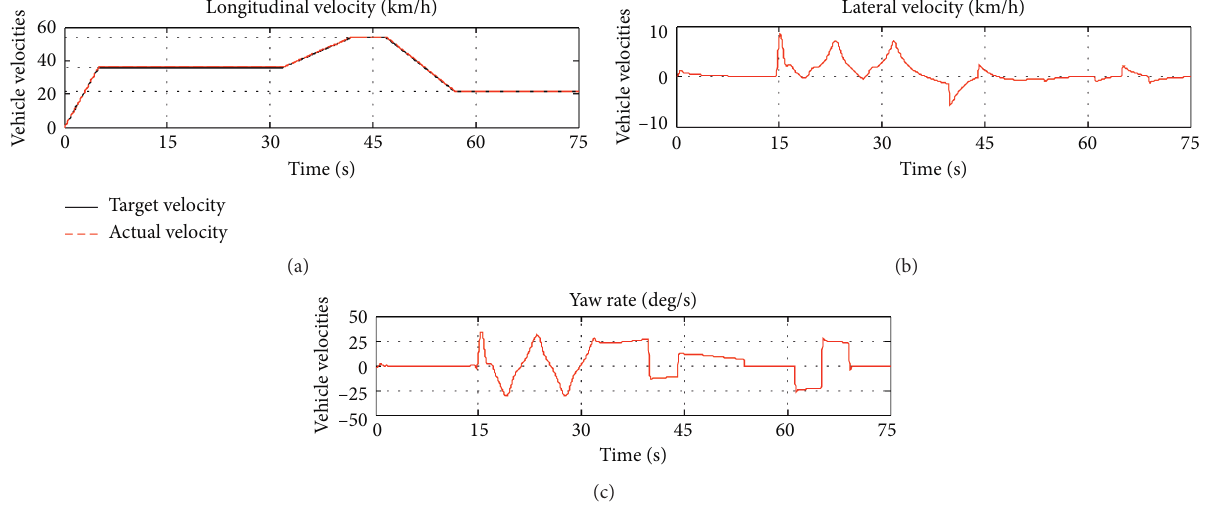
Figure 22: Time histories for longitudinal and lateral velocities and yaw rate of the path-following vehicle.